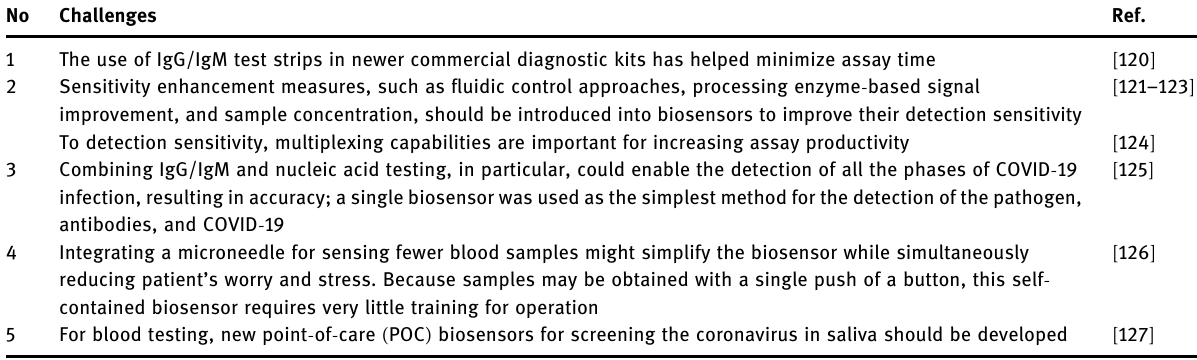
Table 2: Common challenges for patient - friendly COVID - 19 biosensors No Challenges